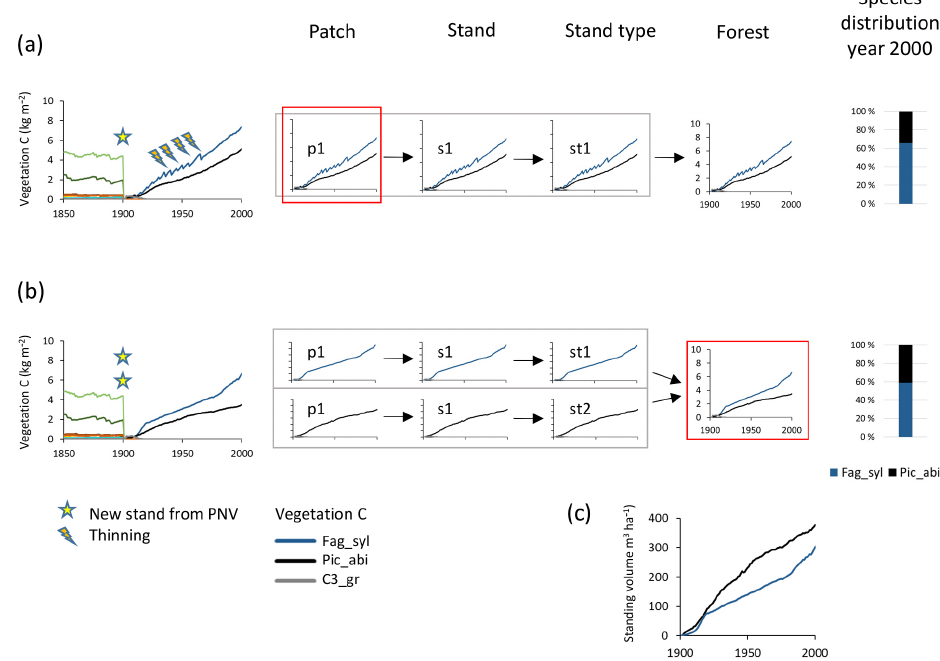
Figure 4. Examples of species structure setup at the patch and forest level. Beech–spruce 60%–40% mixes are created after clear-cutting of PNV. (a) Within-patch setup with the following characteristics: one secondary stand with one patch created in 1901; mixed beech–spruce with selective thinning (target cutting to a 60% / 40% biomass ratio). (b) Among-stand type setup with the following characteristics: two secondary stands (beech and spruce monocultures) with one patch created in 1901 with 60% and 40% groundcover area fractions. (c) Relative development of standing volume of beech and spruce in their separate stands in (b) . Species abbreviations are as follows: Fag_syl, Fagus sylvatica ; Pic_abi, Picea abies ; C3_gr, C 3 grass. Location, climate input, and species in PNV are as in Fig. 2. Table 1. Detailed forest management options. All management options except re-establishment can be defined in separate management types (see Fig. 1), which may be selected in a stand type rotation scheme at pre-defined calendar